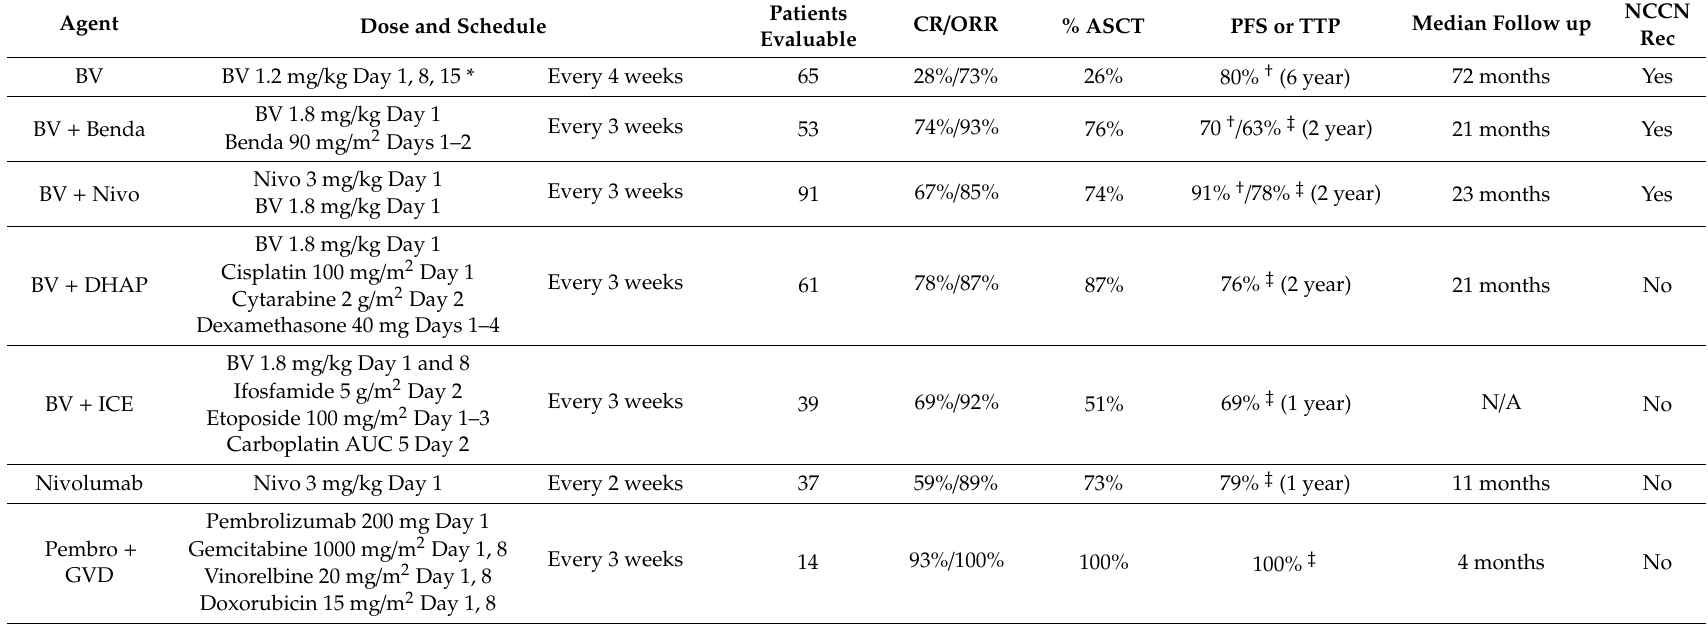
Table 2. Novel and investigational salvage approaches for r / r classical Hodgkin